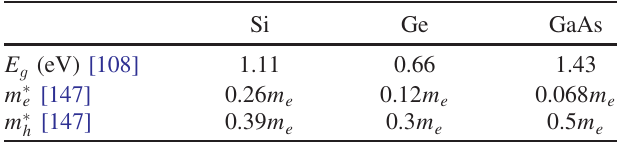
TABLE III. The room-temperature band gap, effective electron mass, and effective hole mass for Si, Ge, and GaAs. Si Ge